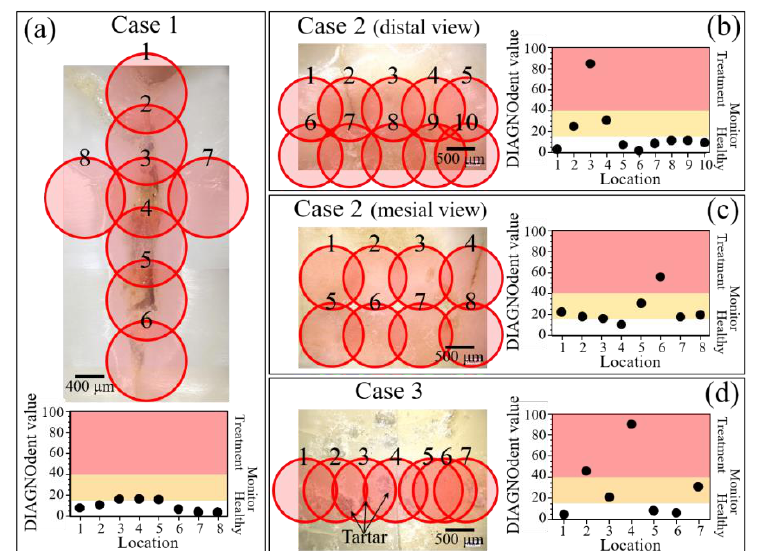
Figure 7. LF analyses of ( a ) Case 1, ( b ) Case 2 (distal view), ( c ) Case 2 (mesial view), and ( d ) Case 3; line scans were performed on each tooth surface and the measurement points were defined as numbers. Graphs in each section represent the severity of the caries according to the DIAGNOdent value expressed as a number between 0 and 100 [20–25].